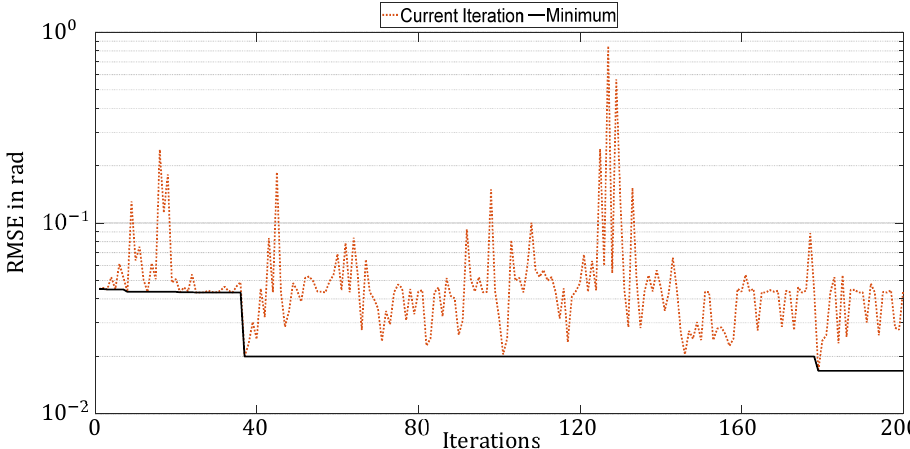
Figure 9. Progress of hyperparameter optimization with Bayesian Optimization over 200 iterations.